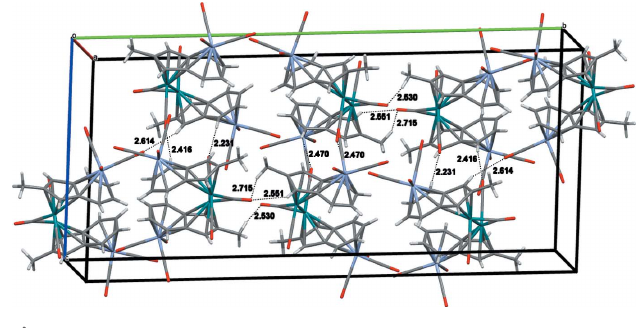
Figure 3 View of the weak C—H (cid:4)(cid:4)(cid:4) O hydrogen-bond network (Table